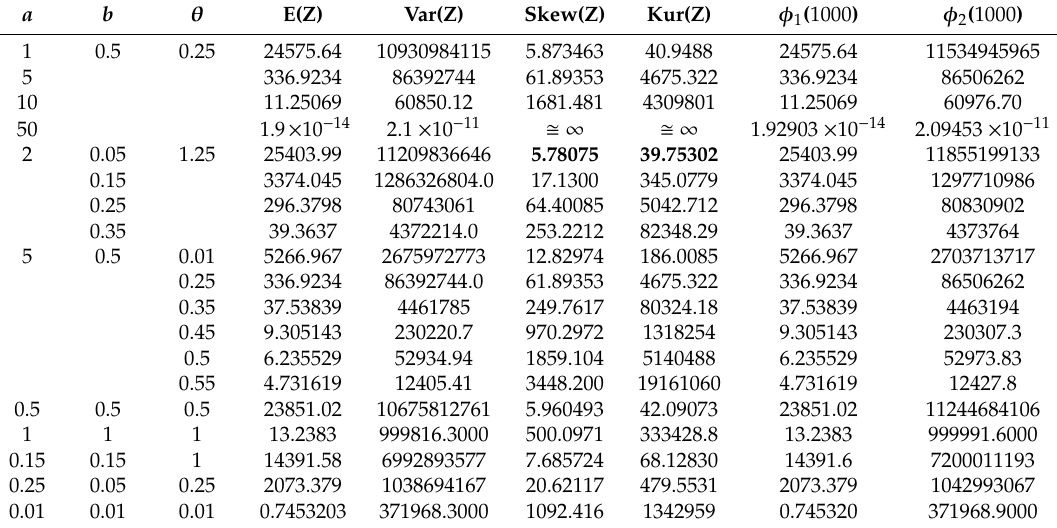
Table 1. E(Z), Var(Z), Skew(Z) and Kur(Z) of the GOLLRW model.